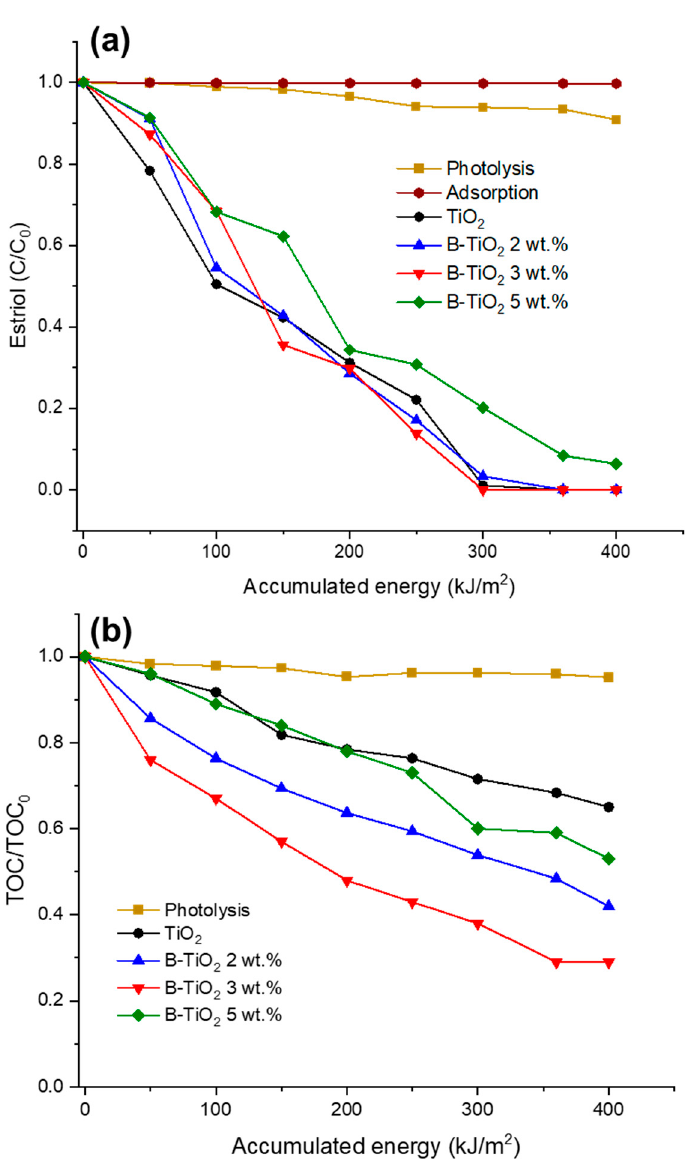
Figure 6. The degradation ( a ) and mineralization ( b ) curves of estriol by photolysis, adsorption, and photocatalysis with TiO 2 and B-doped TiO 2 using 0.5 g/L for the catalyst loading. As observed, the direct photolysis was negligible for E3 degradation, and only 6.5% of the hormone at 400 kJ/m 2 of the accumulated energy was decomposed by solar radiation. In addition, the test with the photocatalyst under dark conditions demonstrated that the estriol adsorption on the B-TiO 2 3 wt.% material was negligible using a catalyst load- ing of 0.5, 1.0, and 1.5 g/L. Synthesized TiO 2 and all B-doped materials, except for B-TiO 2 5 wt.%, achieved the complete degradation of estriol at 300 kJ/m 2 of the accumulated en- ergy. Otherwise, for the solutions with the dissolved hormone treated with 1.0 and 1.5 g/L of the different modified catalysts (Figure S1), a complete degradation was obtained at 300 kJ/m 2 of the accumulated energy. Nevertheless, at 200 kJ/m 2 , by using 1.0 g/L of the B- TiO 2 3 wt.% sample, a higher degradation percentage (94%) was achieved. On the other hand, when B-TiO 2 2 wt.% and B-TiO 2 5 wt.% were used, only 77% and 69% degradation percentages, respectively, were reached (Figure S1a). In comparison, in a research work that employed a three-dimensional electrode reactor, an 80% removal efficiency of E3 was obtained [11], while in another study, complete degradation after 480 min with 0.3 Fe-